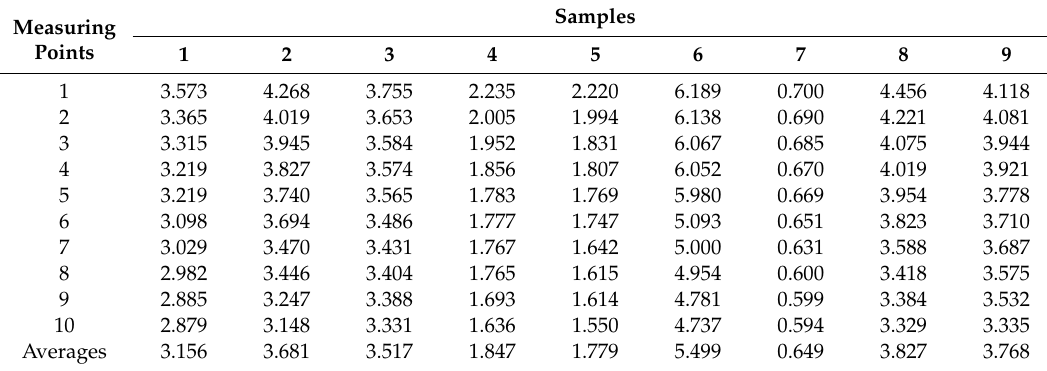
Table 5. Amount of deformation in the thickness direction (mm).